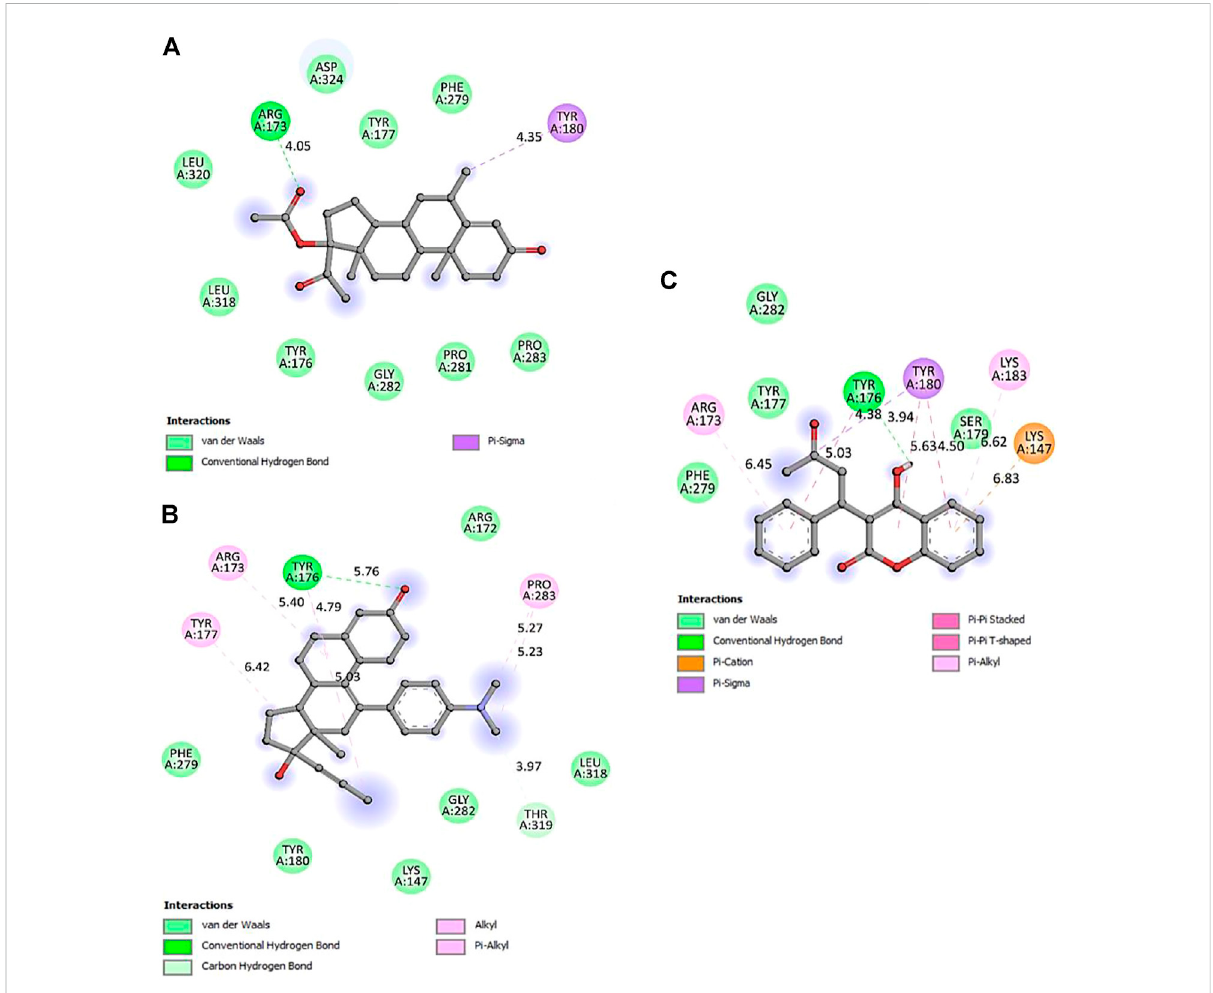
FIGURE 7 2D representation ofPTEN protein-interacting residuesincomplexedwith (A) -5bzx-Medroxyprogesterone Acetate, (B) -Mifepristone, and (C) -